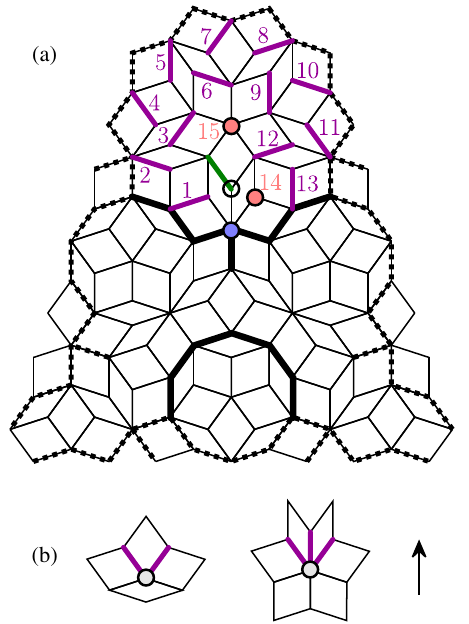
FIG. 6. Elements used in the proof that (a) a 6-vertex (blue) cannot host a monomer in a maximum matching, and (b) the dimer which must emanate from the 6-vertex must be placed on one of the three purple edges indicated. The direction of the 4- and 6-vertices is defined to align with the arrow. Thick black lines indicate edges which cannot be covered by dimers in maximum matchings. Solid (dashed) lines indicate definite (potential) uncoverable edges. Potential uncoverable edges are those that may or may not become uncoverable depending on how the local empire overlaps with others in the full